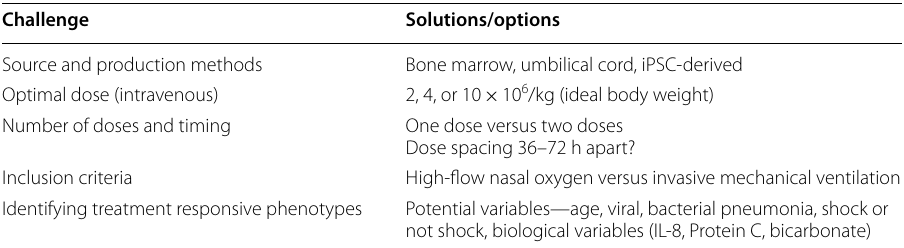
Table 4 Challenges for testing mesenchymal stromal cells for